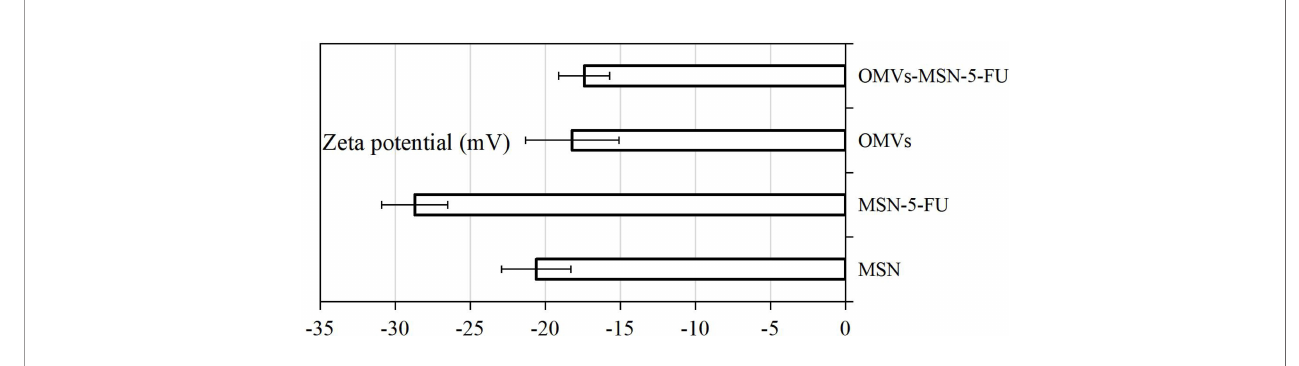
FIGURE 5 | Average Zeta potential plot.